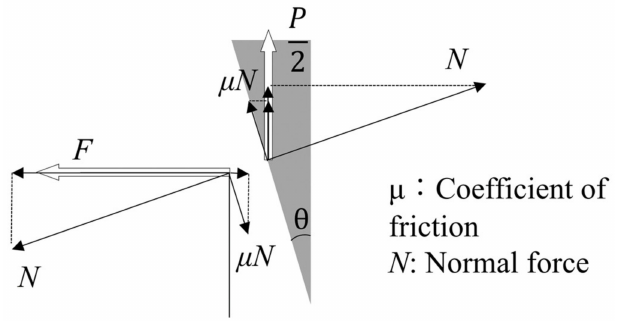
Figure 7. Force equilibrium between specimen und